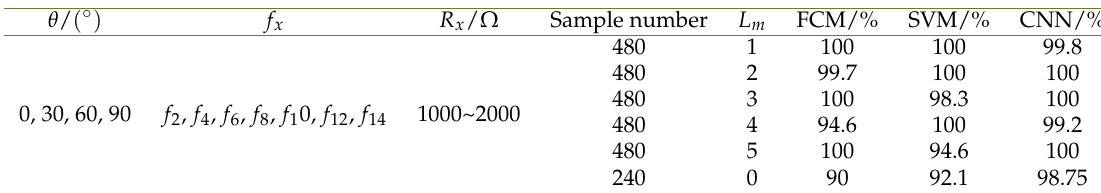
Table 6. Testing results of line selection of high-resistance grounding fault